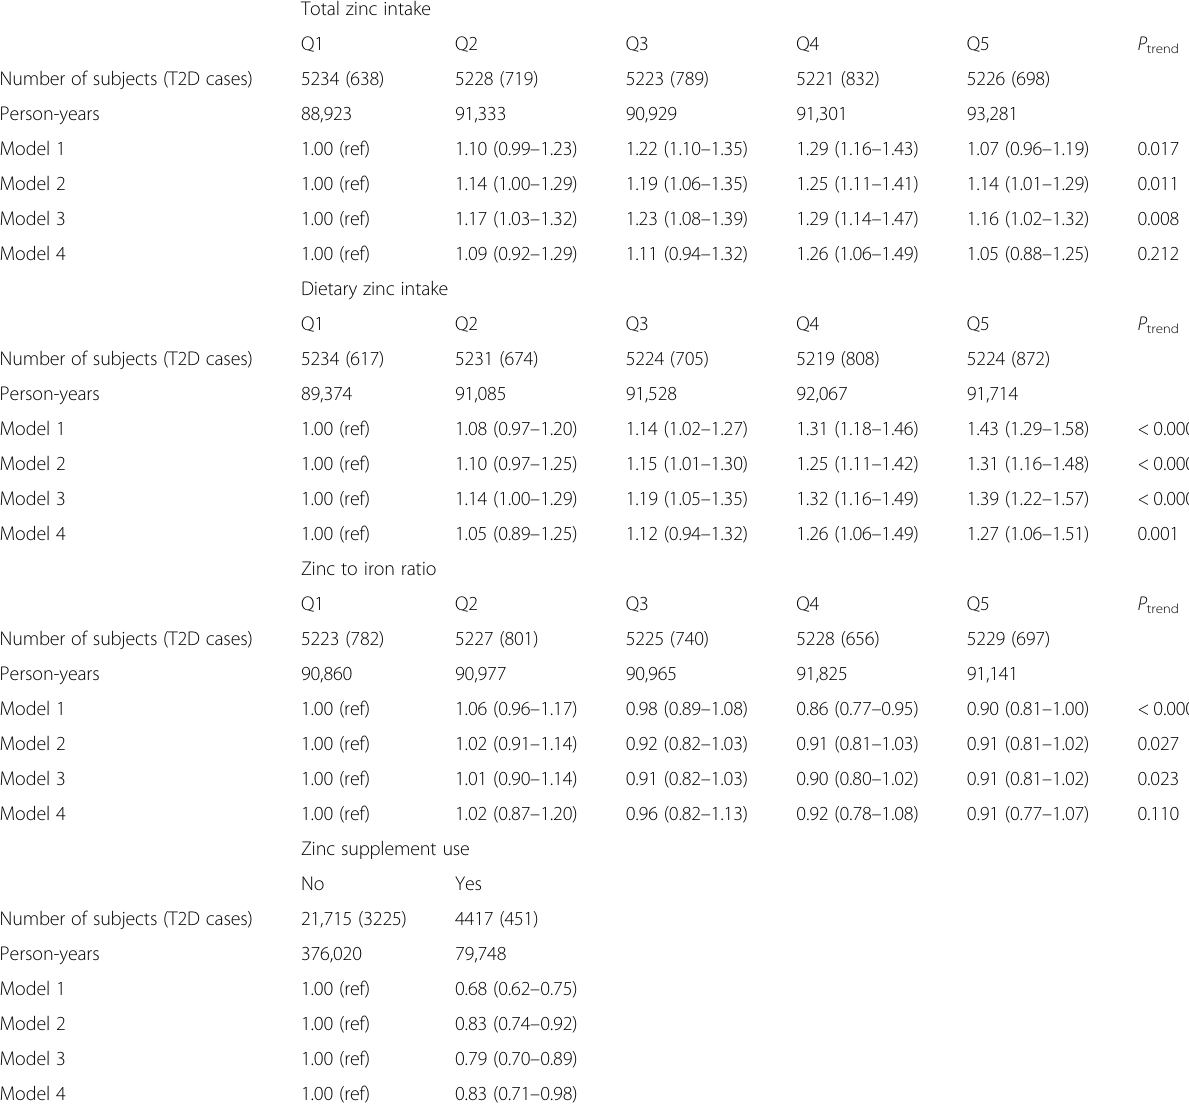
Table 2 Hazard ratios (HRs) and 95% confidence intervals (CIs) for type 2 diabetes (T2D) by quintiles (Q) of energy-adjusted total and dietary zinc intake, zinc to iron ratio, and zinc supplement use (yes/no) in the Malmö Diet and Cancer Study (1991 –